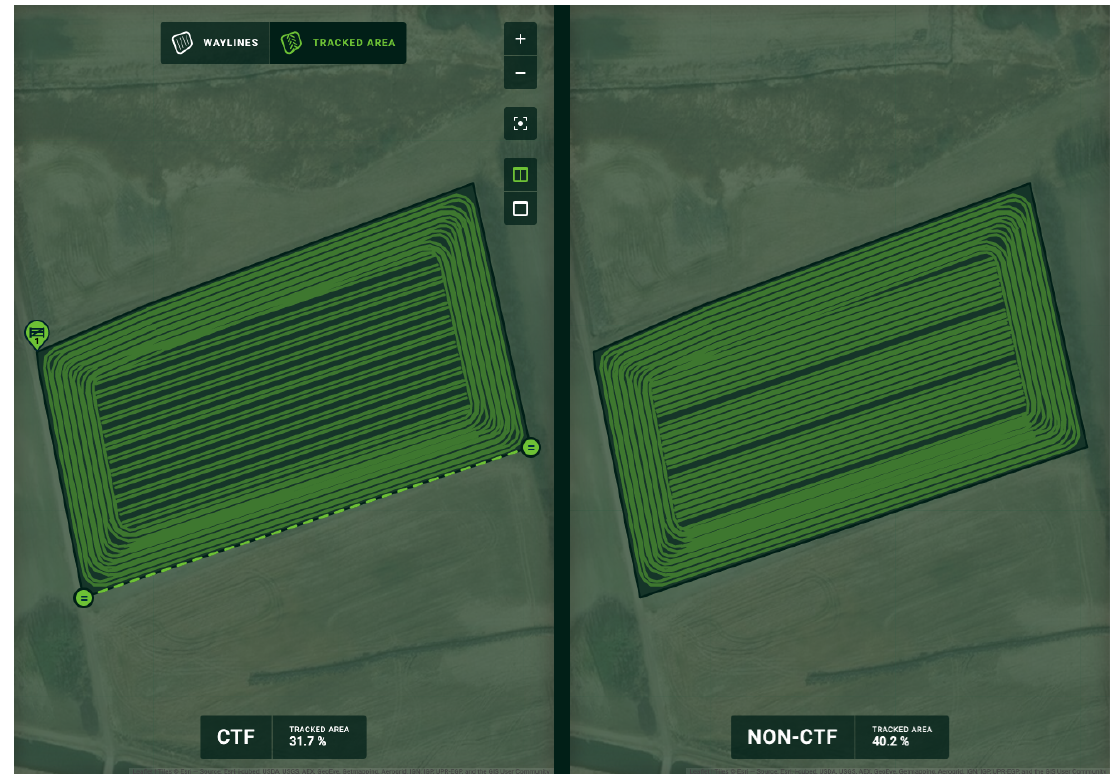
Figure 4. Controlled traffic farming: Tracked area for all three